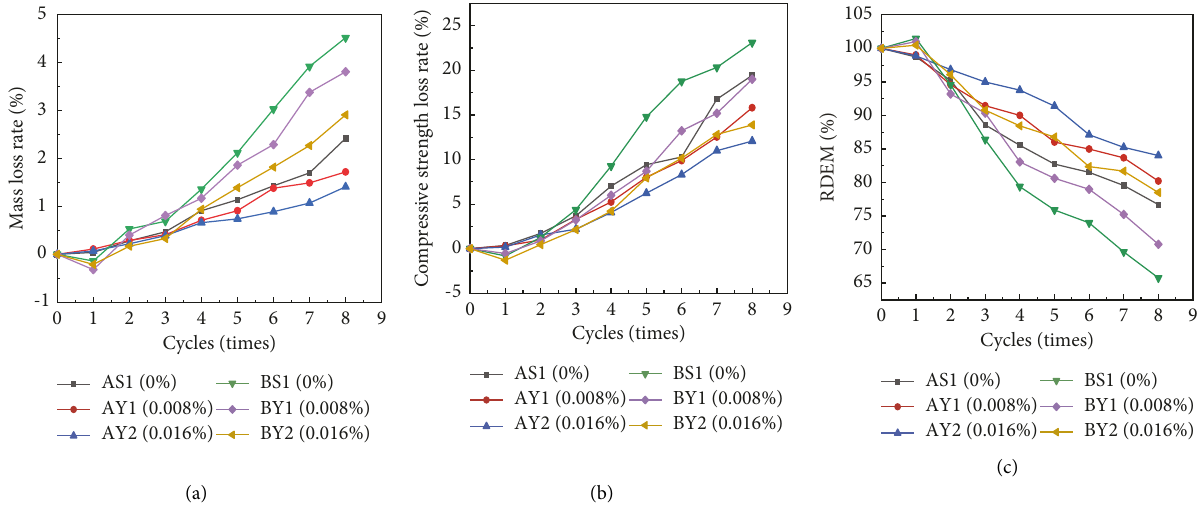
Figure 4: Variation curves of concrete macro-indices with different air-entraining agent dosages. (a) Mass loss rate. (b) Compressive strength loss rate. (c)